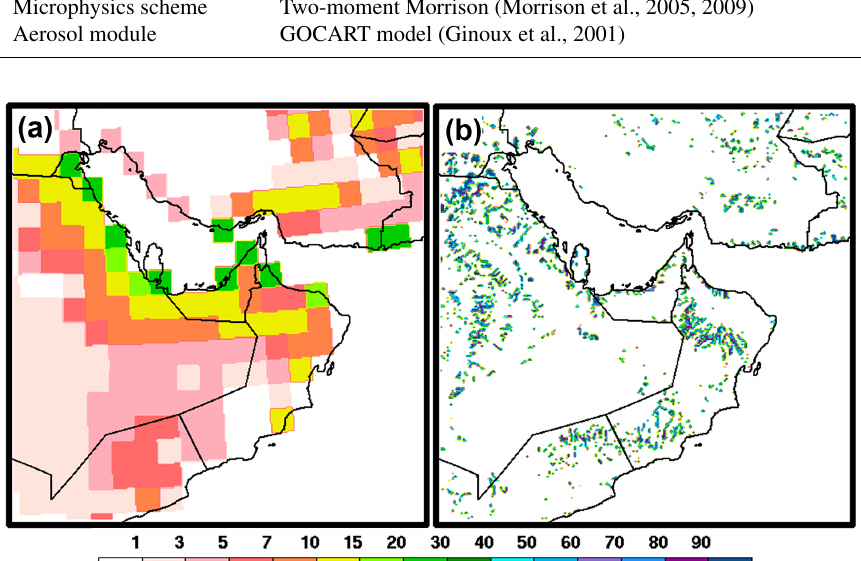
Figure 2. Erodible fraction potential for utilization in the dust-lofting parameterization from (a) Ginoux et al. (2001) 1 ◦ dataset and (b) Walker et al. (2009) high-resolution (1km) database developed at the Naval Research Lab (NRL). Both datasets are shown mapped to the RAMS 2km grid spacing domain. Values represent 0%–100% erodible